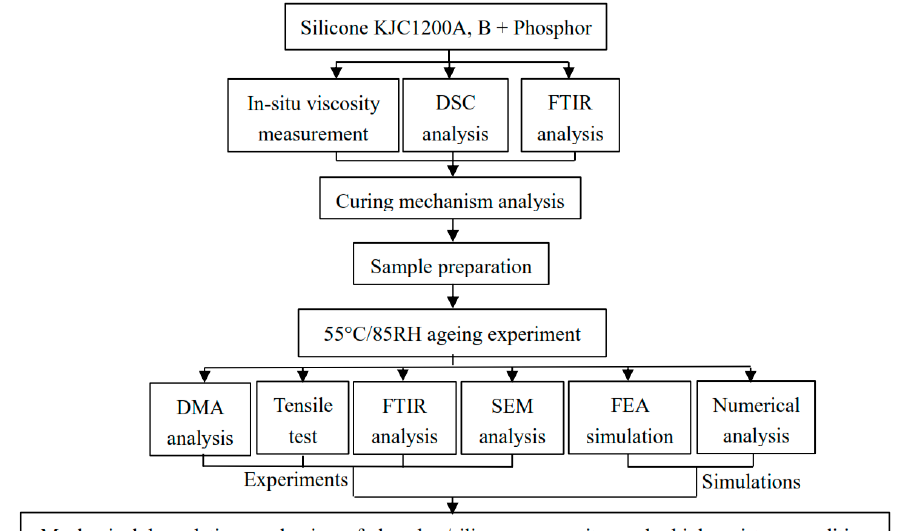
Figure 3. The flowchart of the study plan.